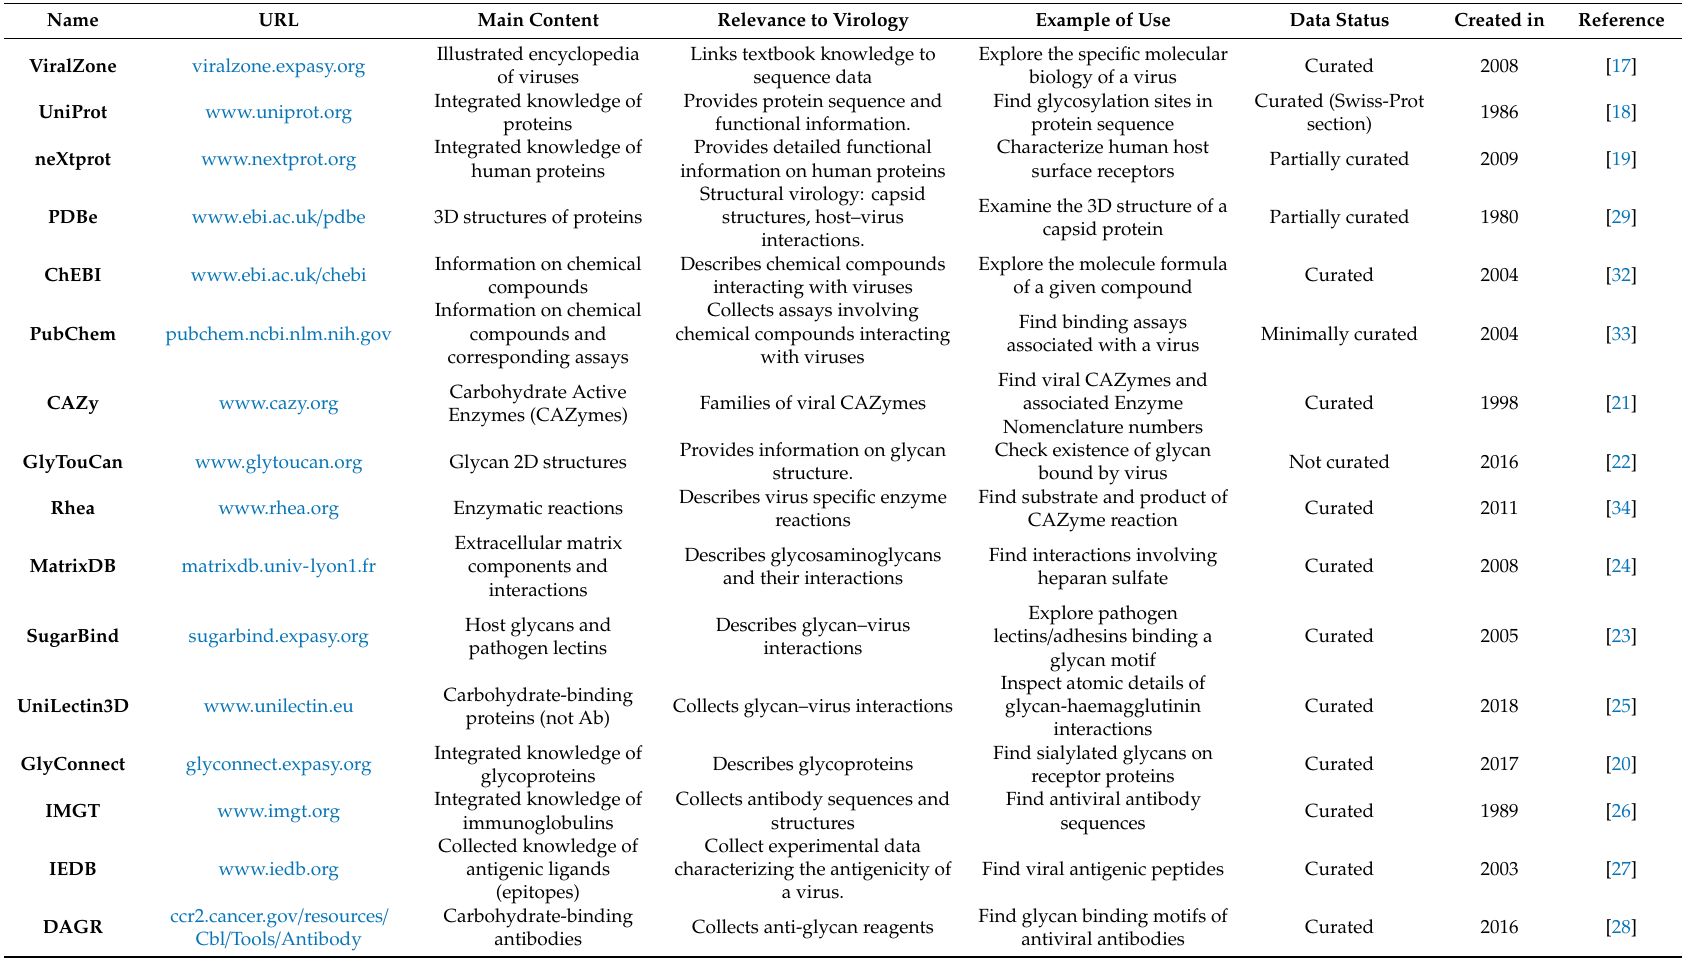
Table 1. The databases pictured in Figure 2 are briefly described and qualified for their relevance to